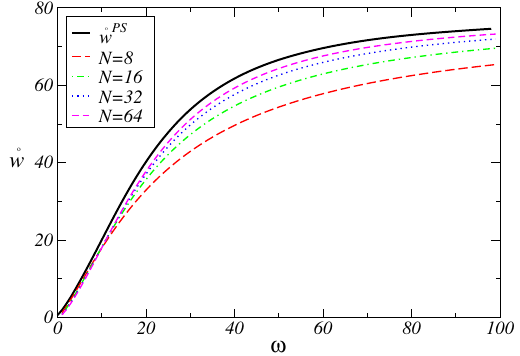
FIG. 8. Rate of work done by the external process _ w as a function of ω ¼ 2 πγ =N . For the periodic steady state, this rate is denoted by _ w PS